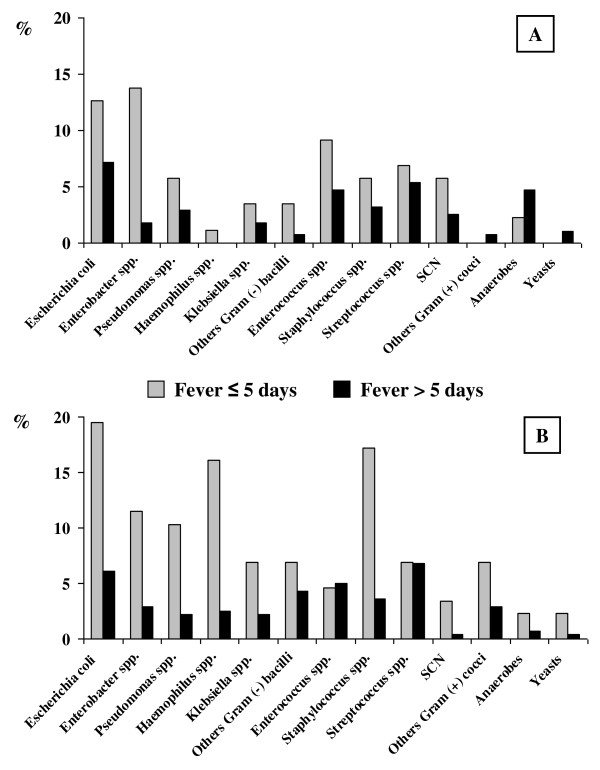
Proportion of microorganisms recovered from normally sterile sites (A) and those cultured from potentially contaminated sites (B). SCN: Staphylococcus coagulase negative. Viruses are not represented (none recovered from sterile sites and two from potentially contaminated sites in the prolonged-fever group).